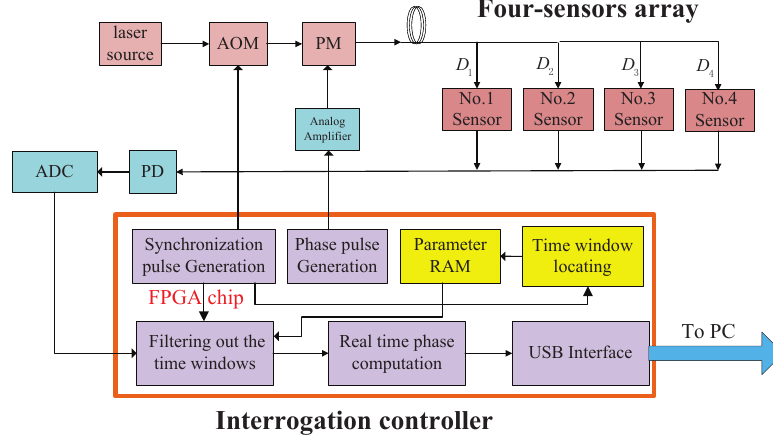
Figure 4. The experimental configuration of a four-sensor TDM